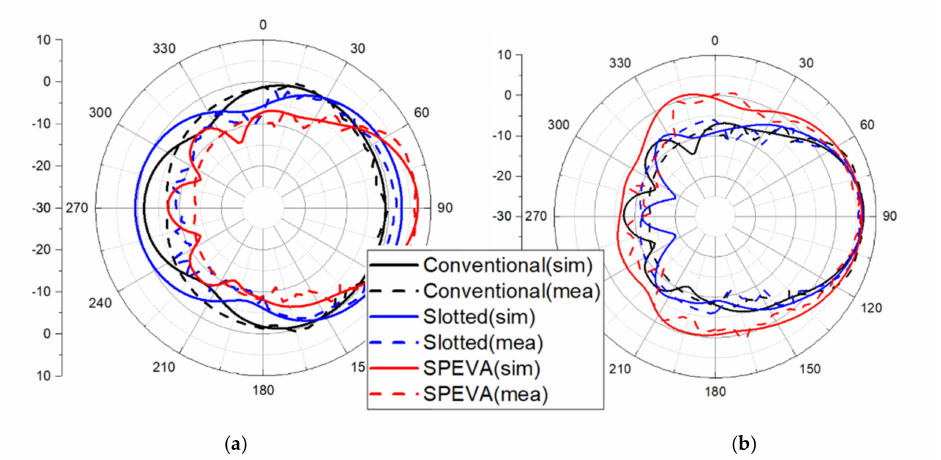
Figure 8. Simulated and measured radiation patterns of three types of Vivaldi antennas ( a ) at 3 GHz and ( b ) 7